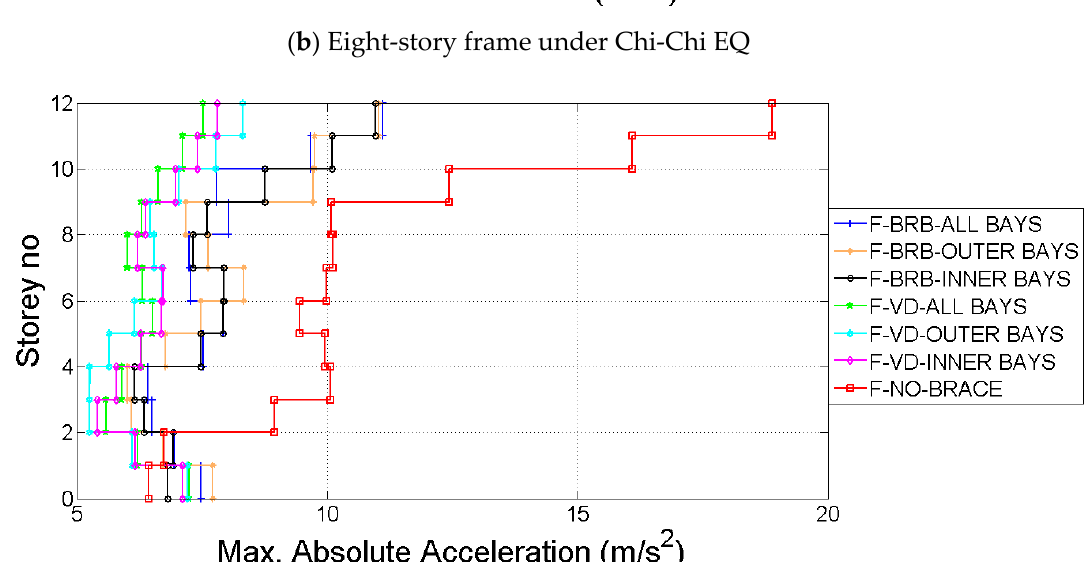
Figure 14. Variation of the maximum absolute accelerations with story level.